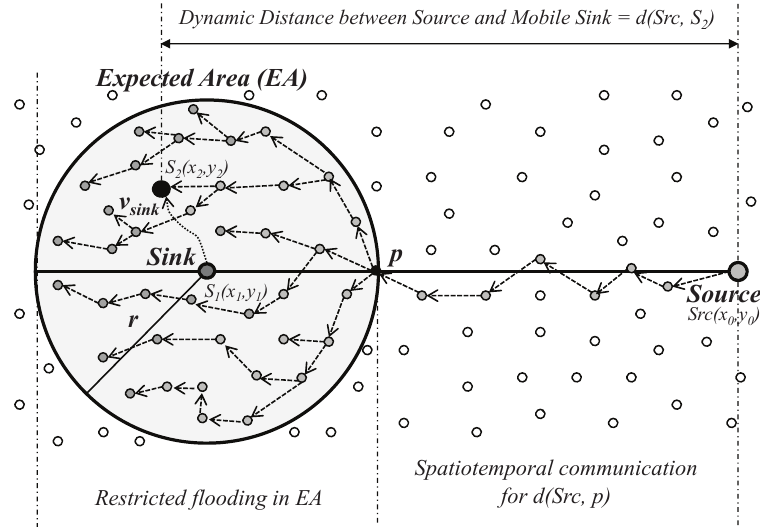
Figure 1. Real-time data routing based on expected area of a mobile